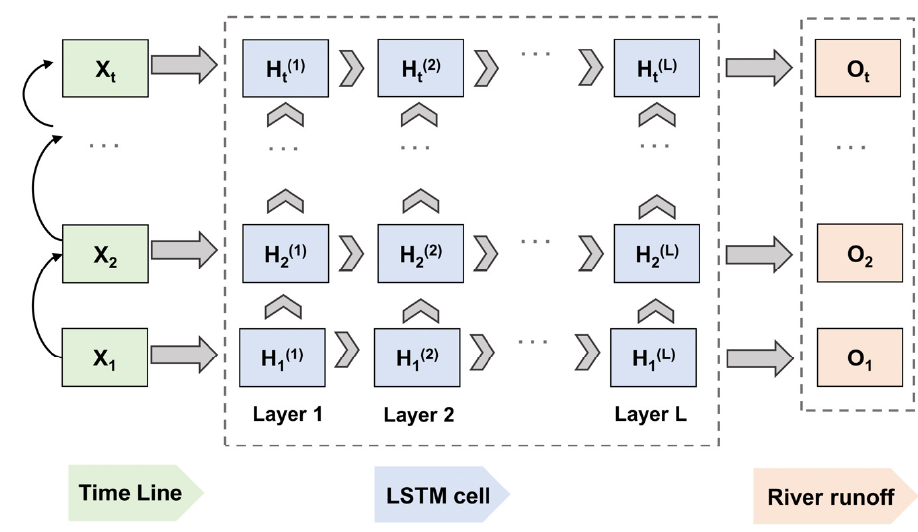
Figure 3. Framework of LSTM model.